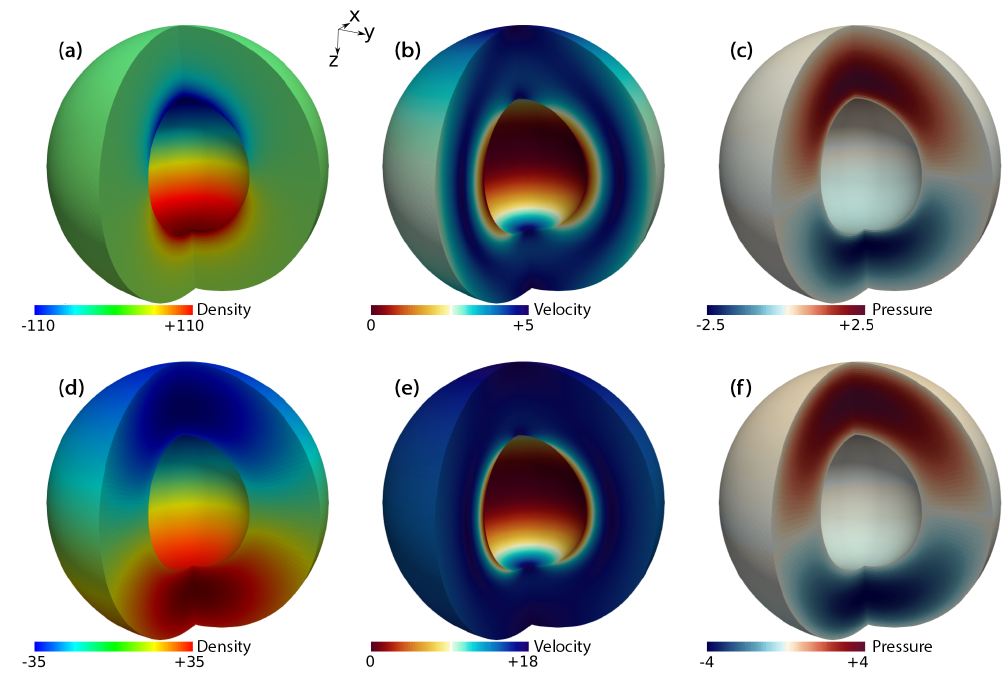
Figure 2. (a–c) Analytical solution for m = − 1 (constant viscosity); (d–f) solution for m = 3.